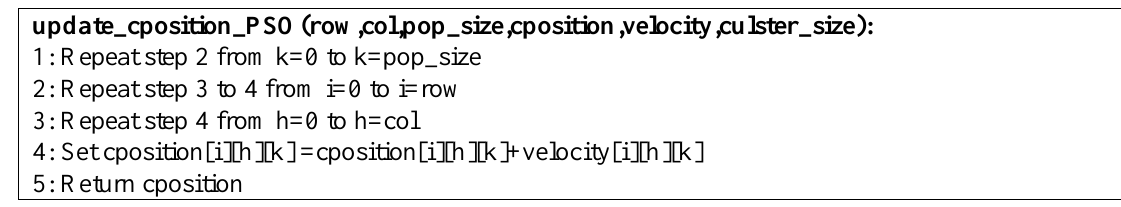
Algorithm 7. Function to update current position of the particle through PSO